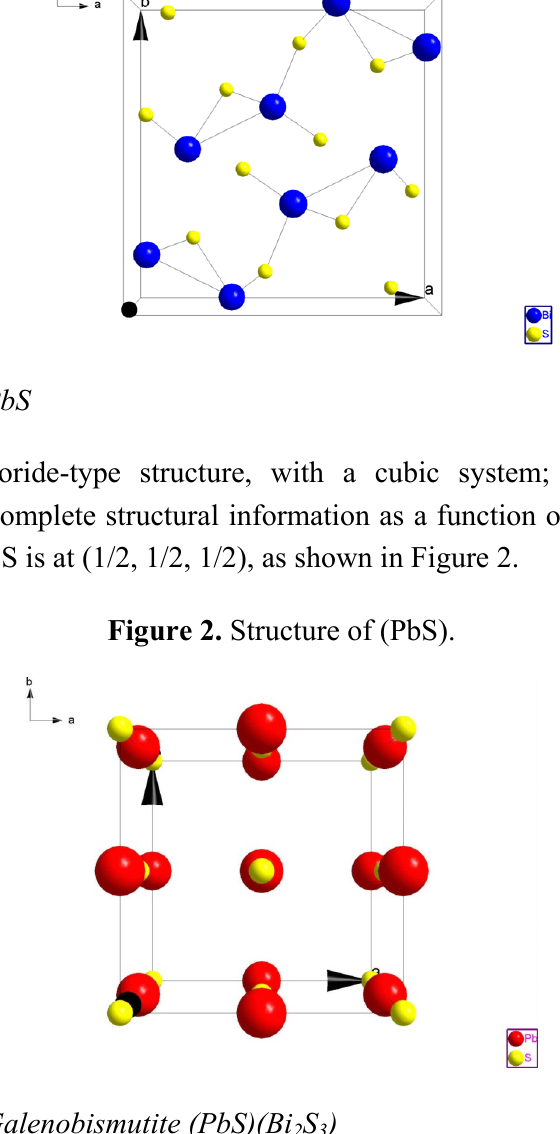
Figure 1. Structure of (Bi